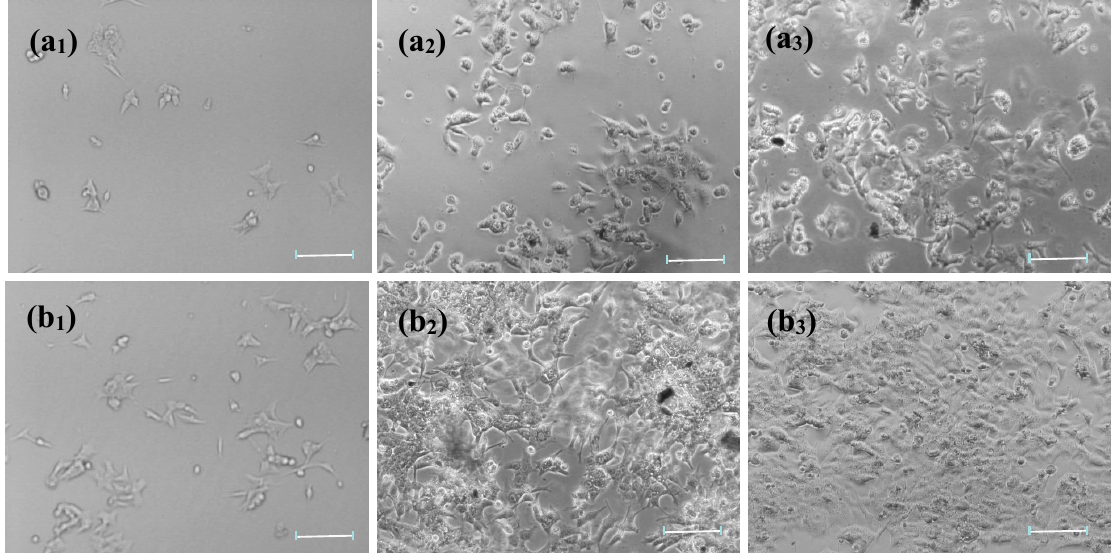
Figure 3. Microscopy images of HCT-116 cells proliferated on ( a ) bare glass and ( b ) HG/glass for ( a 1 , b 1 ) 12 h, ( a 2 , b 2 ) 24 h, and ( a 3 , b 3 ) 48 h respectively. Scale bar = 100 μ m.